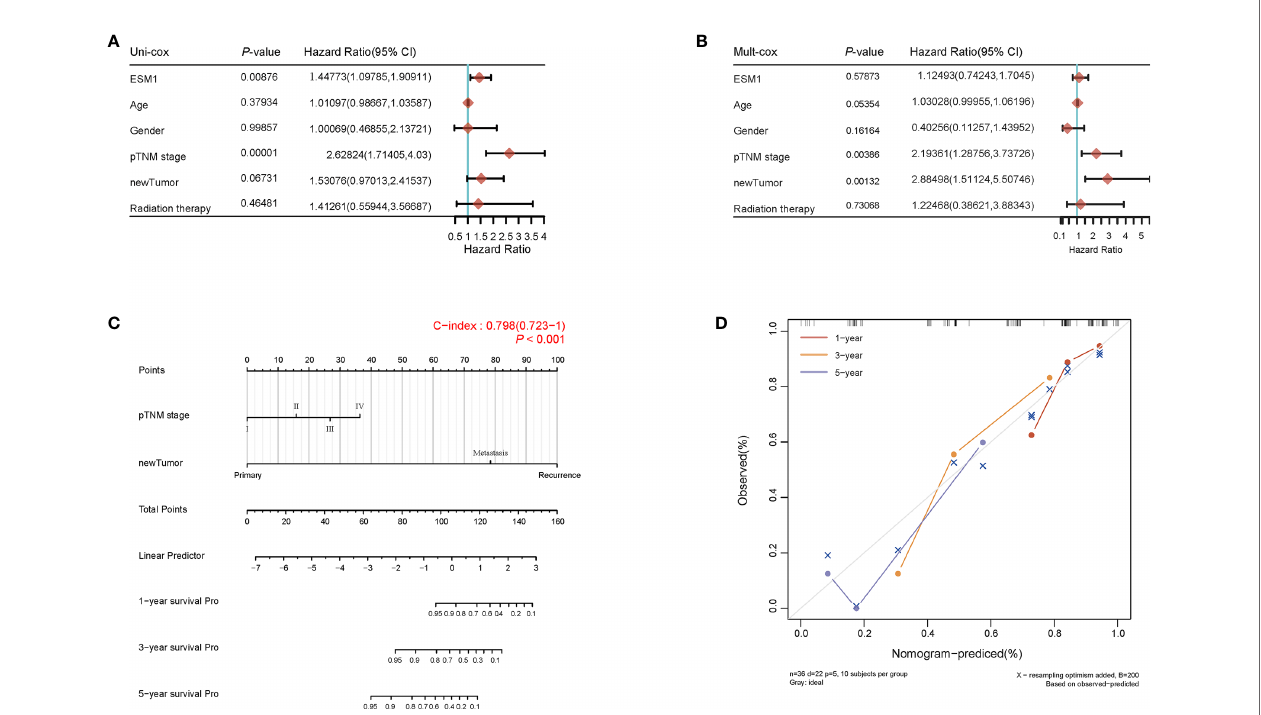
FIGURE 4 | Prognosis analysis of ESM1 expression in ACC patients. The p -value and hazard ratio of ESM1 and associated parameters of the uni-Cox (A) and multi-Cox (B) analyses. (C) Nomogram for assessing 1-, 2-, and 3-year survival rate in ACC patients related to ESM1 expression. The nomogram provided a graphical representation of the factors, which can be used to calculate the risk of recurrence for an individual patient by the points associated with each risk factor. (D) The calibration curve of the nomogram. The closer the nomogram model is to the calibration curve, the better the prediction result of the